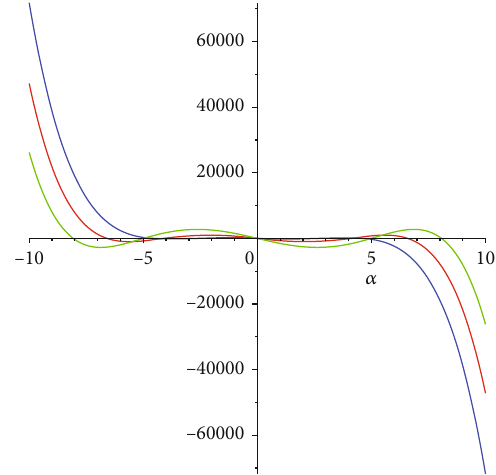
Figure 3: The behavior of stability analysis β ð α Þ and wave number α with the disparate amounts θ = 1, θ = 2, θ = 3 .